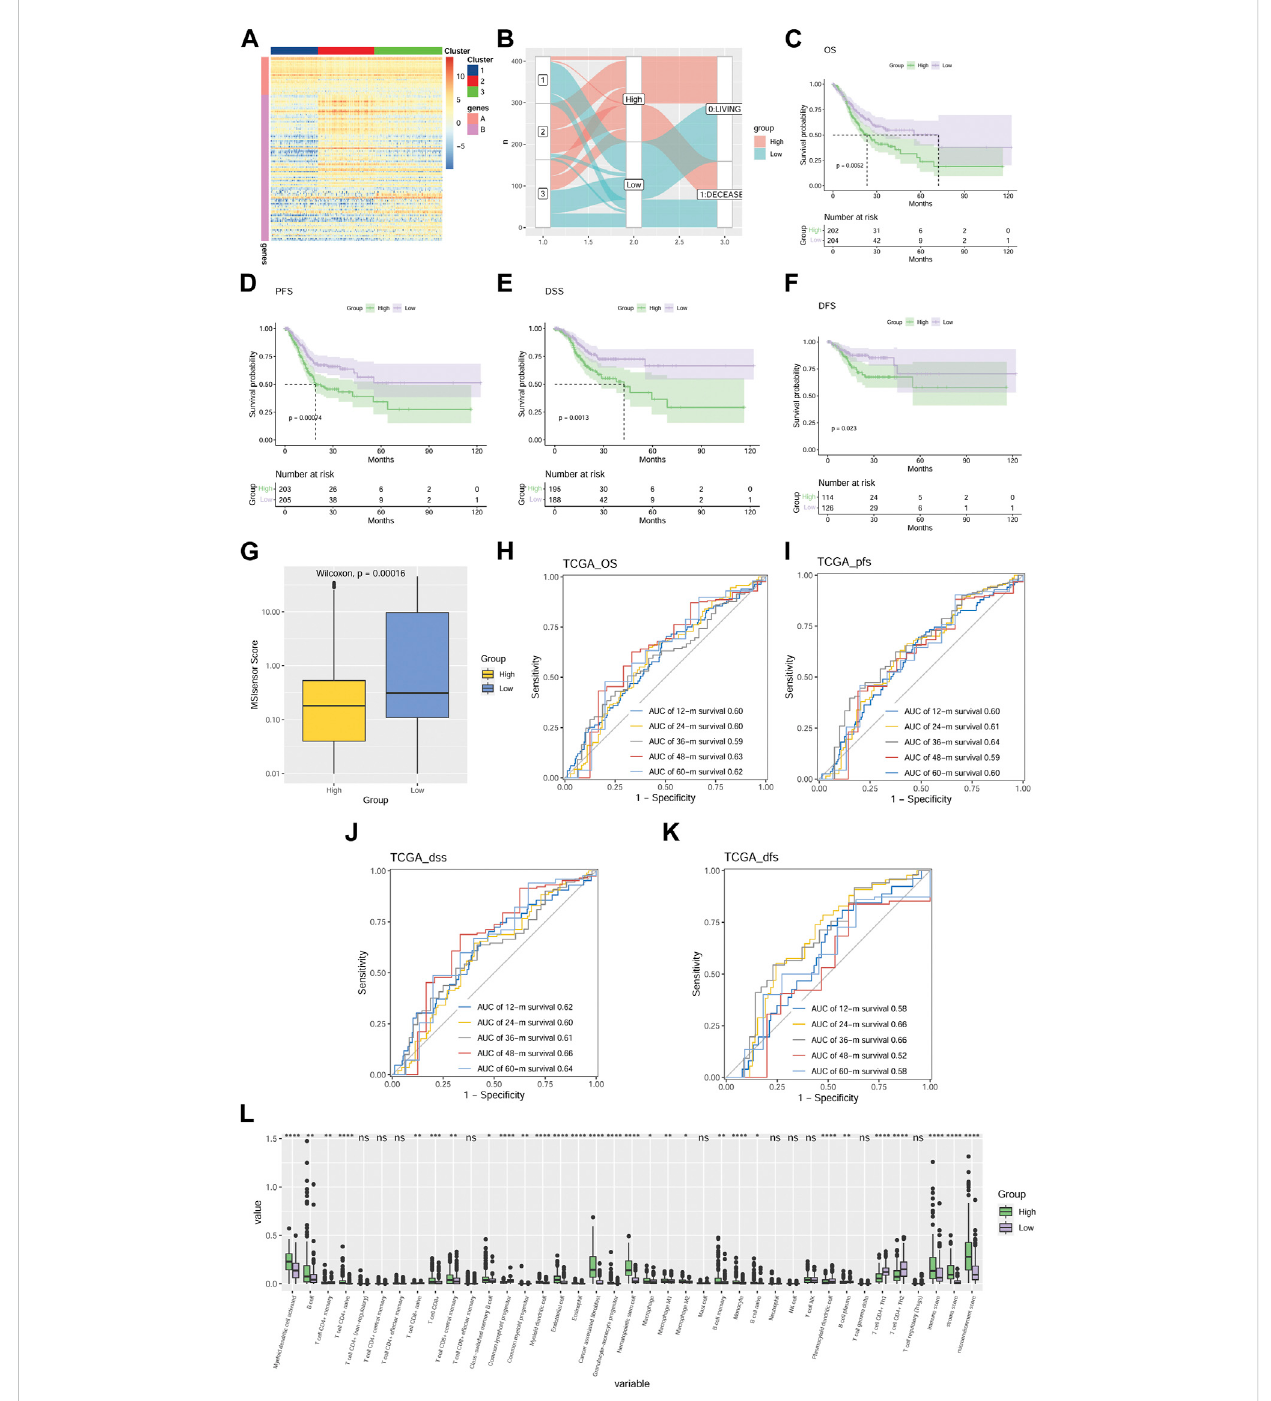
FIGURE 3 Development of an MMP scoring system for GC patients (A) Heat map depicts the expression situation of the 126 most abundant DEGs in the genome in three different gene clusters. Those DEGs are divided into Signature A and B genes. Each row represents one DEG. The higher the expression level of a DEG, the redder the color, and the lower the bluer. (B) Alluvial plots depicting the relationship between three molecular models, MMP scores, andsurvival status. Kaplan-Meier survivalanalysis comparing thedifferences inOS (C) , PFS (D) , DSS (E) ,and DFS (F) among thethreegroups. (G) Box plots show the difference in MSI scores between the two groups. ROC is based on MMP scores for OS (H) , PFS (I) , DSS (J) , and DFS (K) . (L) Box plot compares the discrepancy of immune in fi ltration level of various immune cells and immune score, stromal score, and microenvironmental score in TME between two groups of patients with MMP scores. The higher the immune in fi ltration and the immune score, stromal score, and microenvironmental score, the higher the value. * p < 0.05; ** p < 0.01; *** p < 0.001; **** p < 0.0001. Ns, not signi fi